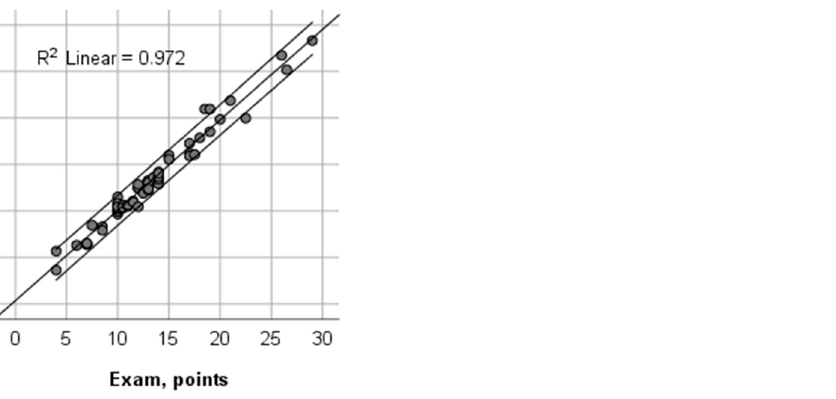
Figure 8. Scatter plot of the predicted values from optimal MARS model MM 1 versus actual values of the target variable Exam with a 5% confidence interval.